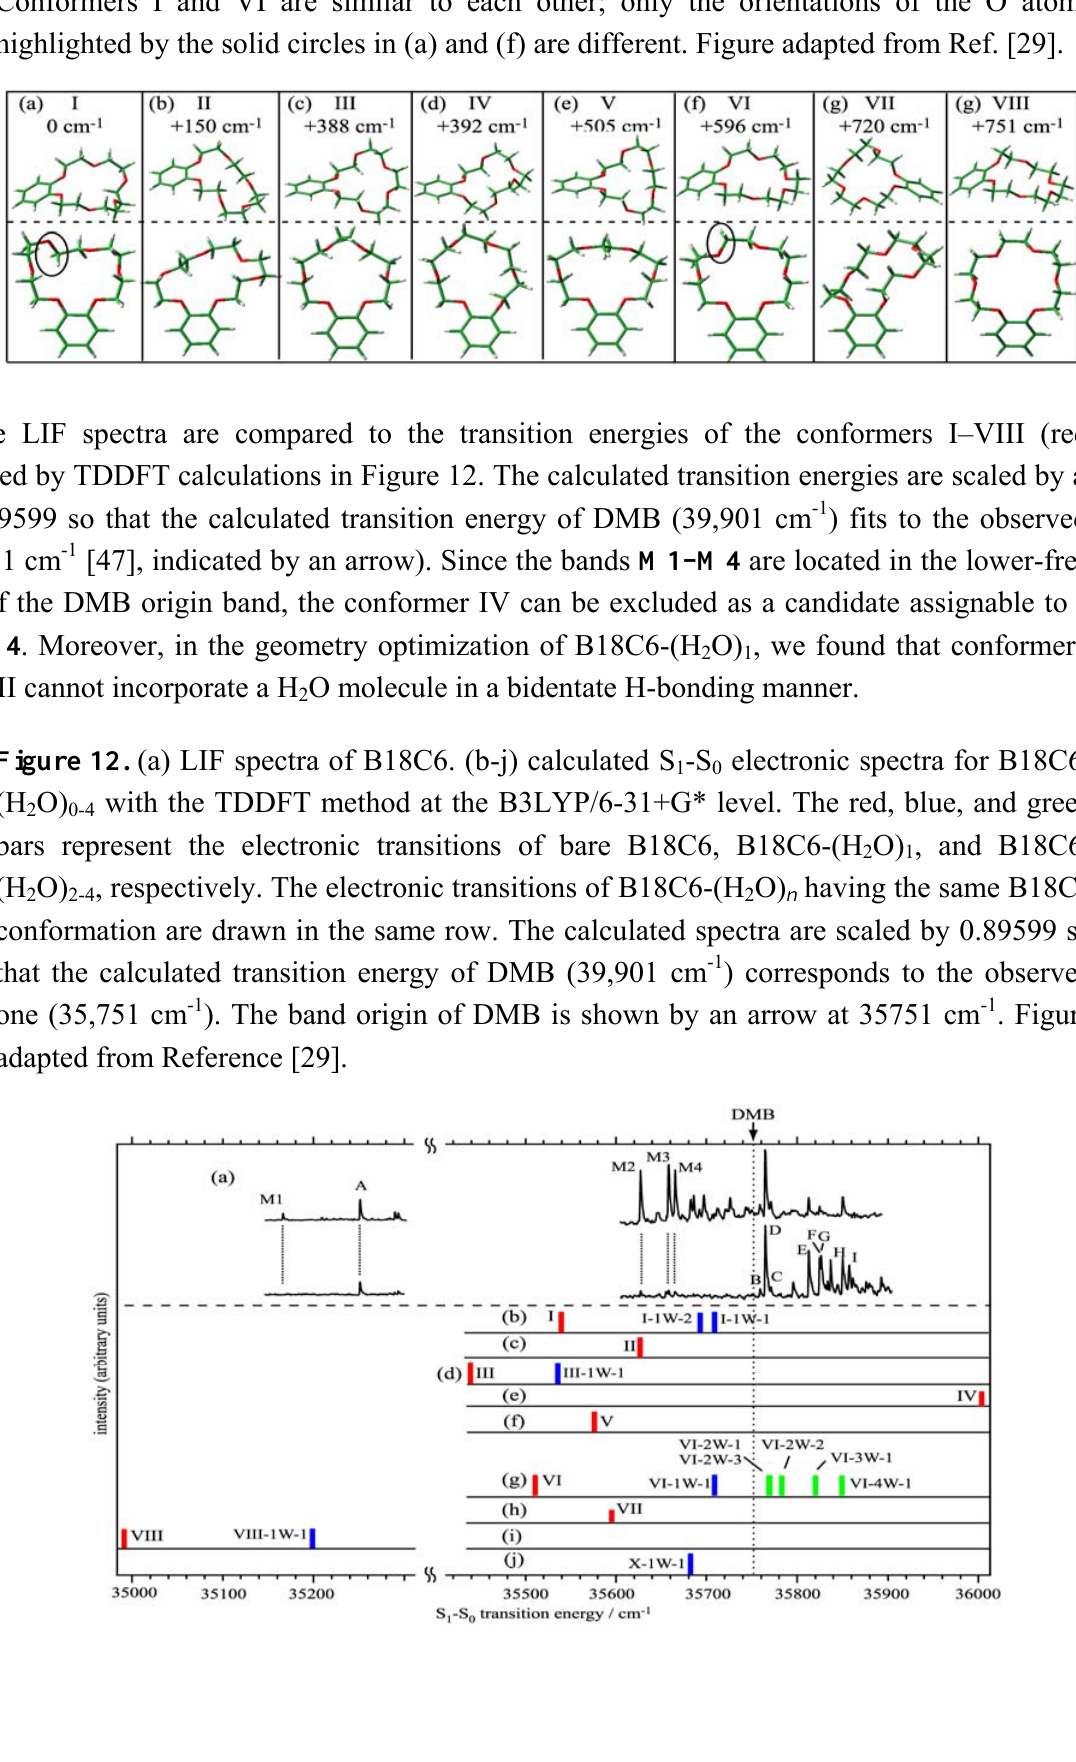
Figure 11. Optimized structures of conformers of B18C6 at the B3LYP/6-31+G* level. The top and side views are shown for each isomer. The numbers shown in cm -1 represent the electronic energies relative to that of the most stable structure (conformer